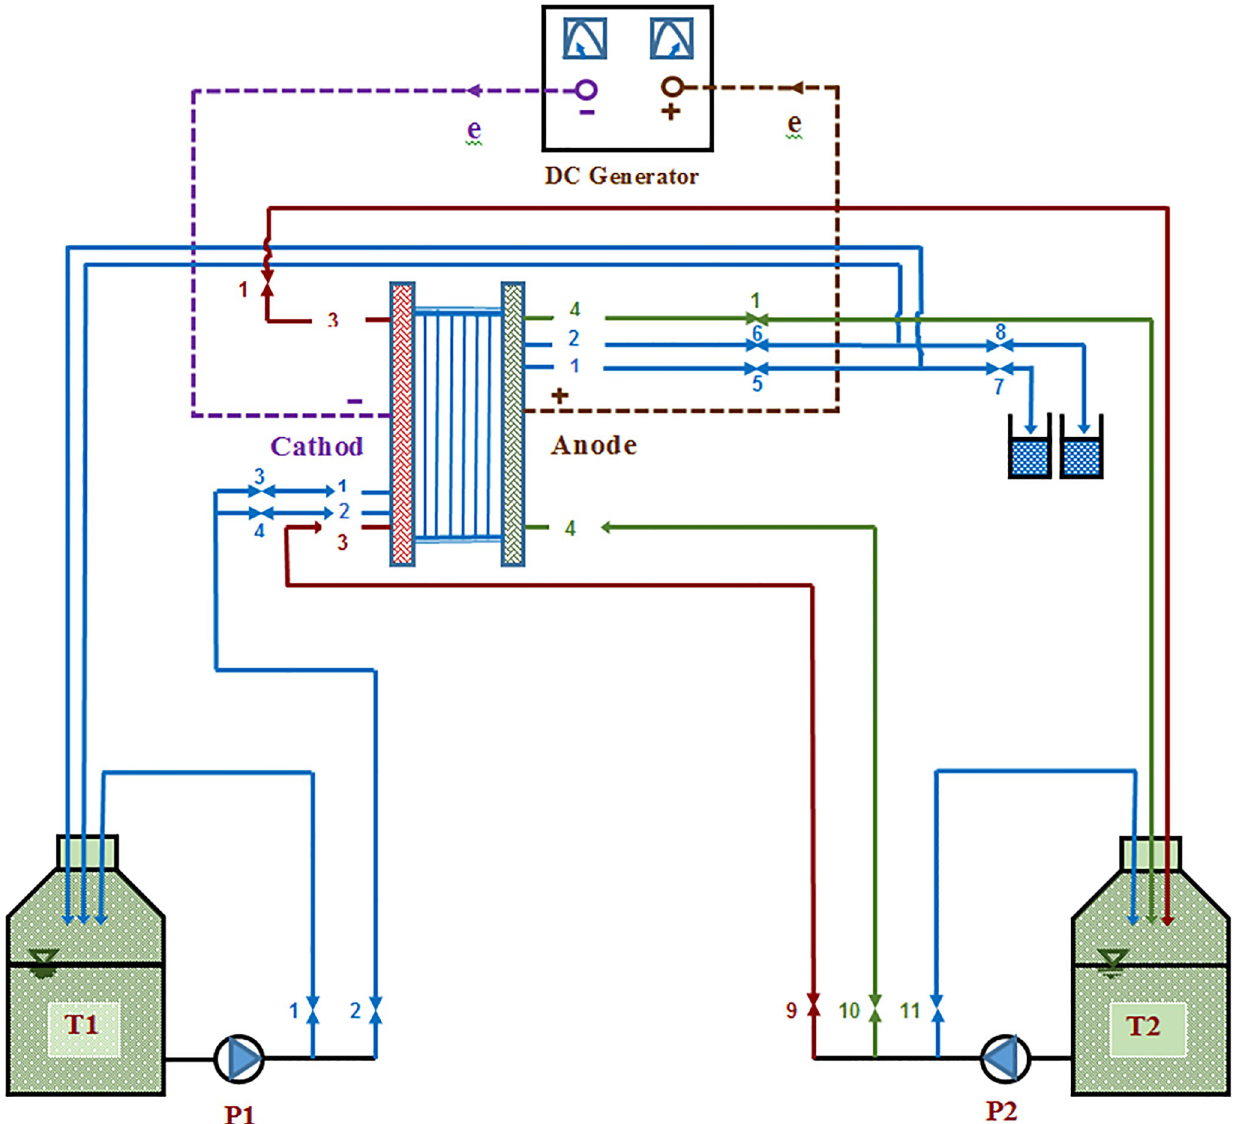
Fig 2. The components of the EDR bench -scale used in this research. T1: concentrated solution tank; T2: electrolyte solution tank; P: electro-pump; DC generator: Direct current generator; Cathode: the cathode pole of electrodialysis; Anode: the anode pole of electrodialysis. (The design and construction of the bench -scale electrodialysis were realized with the collaboration of Mr. Amirreza